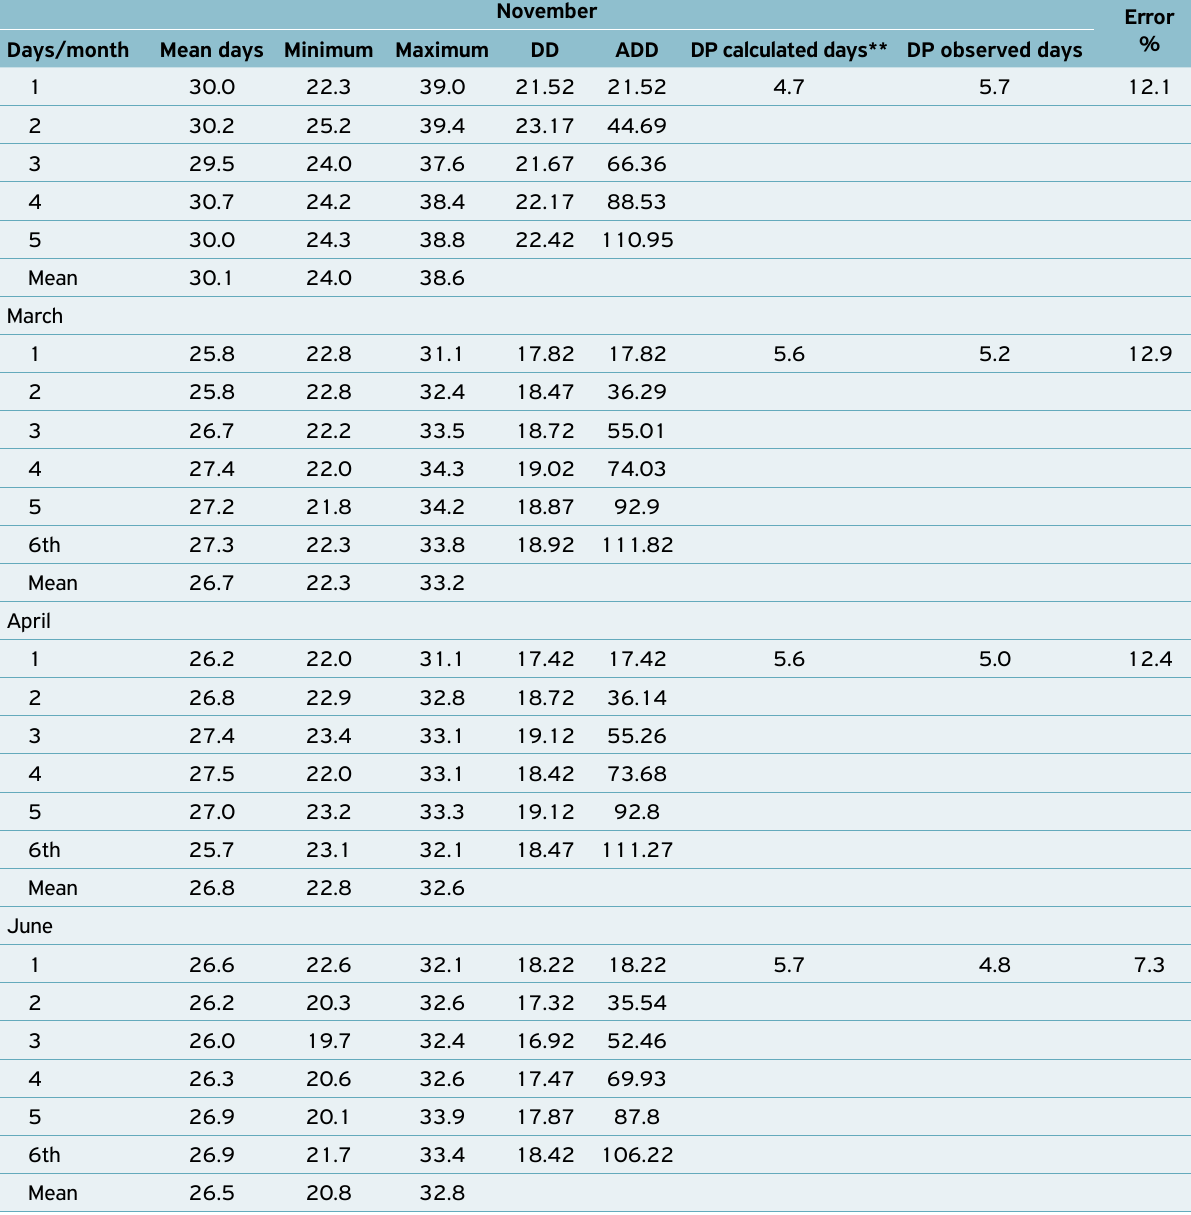
Table 5. Developmental periods of black cowpea aphids from birth to adulthood based on their thermal requirements considering the lower base temperature of 9.13°C and the thermal constant of 99 degree days, as obtained in the laboratory. Teresina, Piauí,